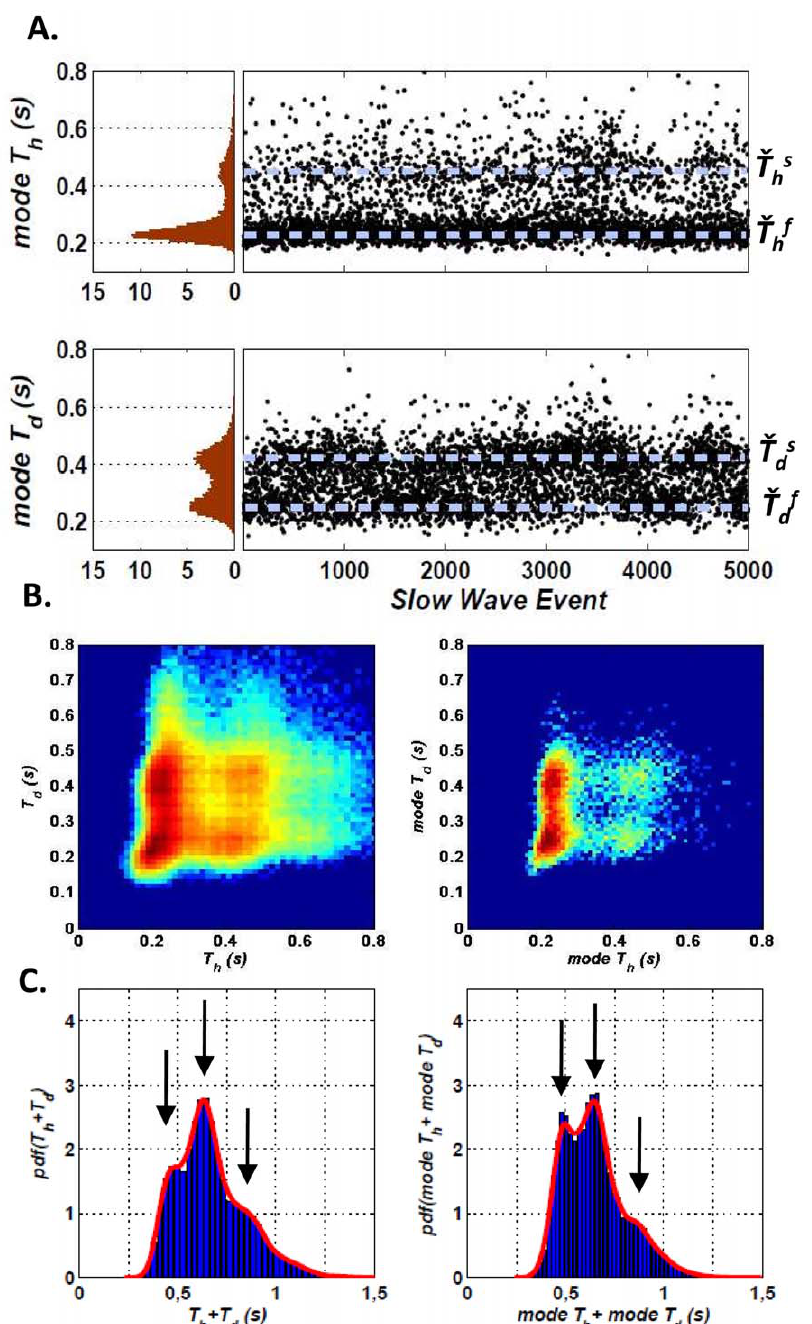
Figure 3. Distributions of mode T h/d and study of the correlation between hyperpolarization and depolarization times. A. Mode T h/d Probability Density Functions of a subject and mode T h/d for each of the events detected in a whole night of sleep (5685 events were detected in that particular night of which only the first 5000 are shown). T ^ f = s mark the position of the typical fast/slow hyperpolarization/depolarization mode times h = d of the events of the subject. B. Left: T d vs. T h for a single subject. Right: mode T d vs. mode T h for a single subject. (A logarithmic scale has been used in both cases for the density color coding). C. Probability Density Function of (T h + T d ) and (mode T h + mode T d ). The continuous lines correspond to the estimated PDF using KDE (See Materials and